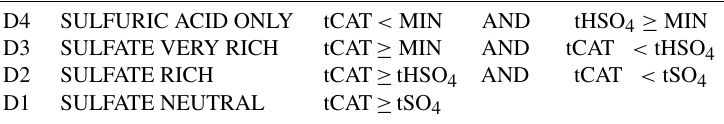
Table 2. Chemical domains (introduced in Sect. 2.2). D4 SULFURIC ACID ONLY tCAT < MIN AND tHSO 4 ≥ MIN D3 SULFATE VERY RICH tCAT ≥ MIN AND tCAT < tHSO 4 D2 SULFATE RICH tCAT ≥ tHSO 4 AND tCAT < tSO 4 D1 SULFATE NEUTRAL tCAT ≥ tSO